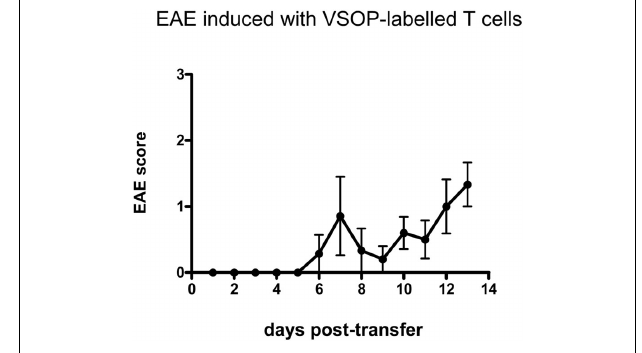
FIGURE 6 |VSOP-labeled cells are able to induce EAE. PLP-specific T cells labeled withVSOP induced EAE in five out of seven SJL mouse recipients. Graph shows mean clinical score, ±